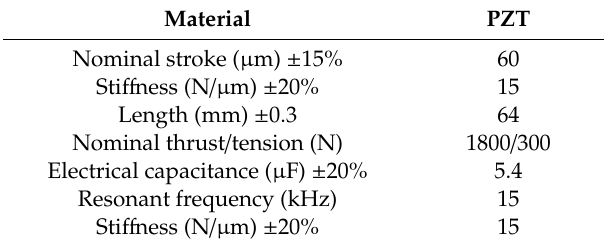
Figure 5. Experimental setup. Table 1. Information about the piezoelectric ceramics actuator (PCA).